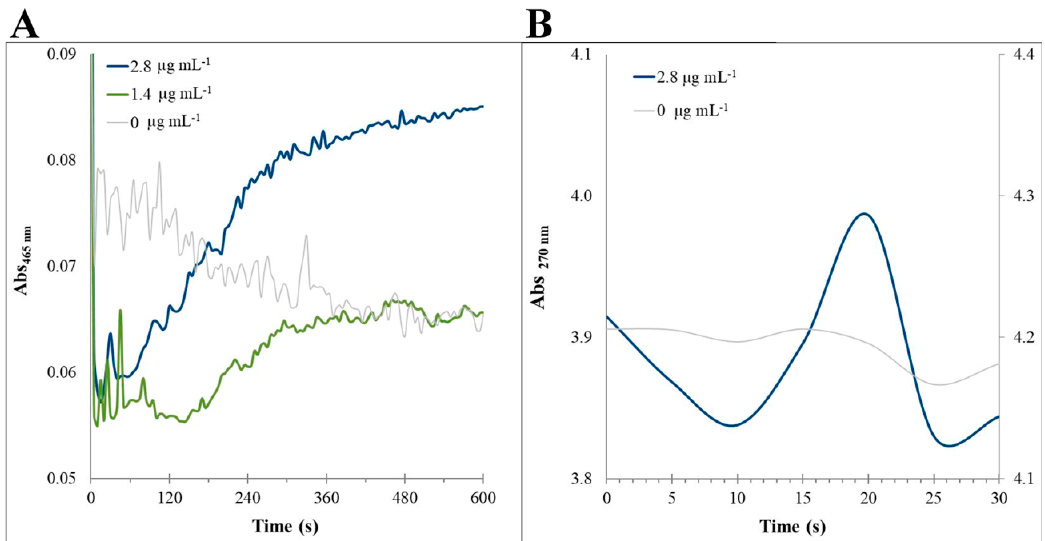
Figure 6. Standard assays for manganese peroxidases. Oxidation of guaiacol and oxidation of Mn +2 assays were both measured by spectrophotometry. In ( A ), the oxidation of guaiacol was measured as the change in absorbance at 465 nm. Reaction mixture contains rMnP1 (2.8 or 1.4 µg mL − 1 ), sodium succinate (500 mM, pH 4.5), guaiacol (100 mM), and MnSO 4 (50 mM). Reactions were initiated by addition of H 2 O 2 (10 mM). For the oxidation of Mn2+ assays ( B ) the oxidation of Mn 2+ to Mn 3+ was followed by measuring the absorbance change at 270 nm. The reaction mixture comprises of rMnP1 enzyme (2.8 µg mL − 1 ), sodium malonate (50 mM, pH 4.5), and MnSO 4 (100 mM). Reactions were initiated by addition of H 2 O 2 (100 mM). The final volume of each reaction mix was 200 µL. The enzyme was omitted (0 µg mL − 1 ) in the reference assays. Plots are representative from each of the triplicate sets.